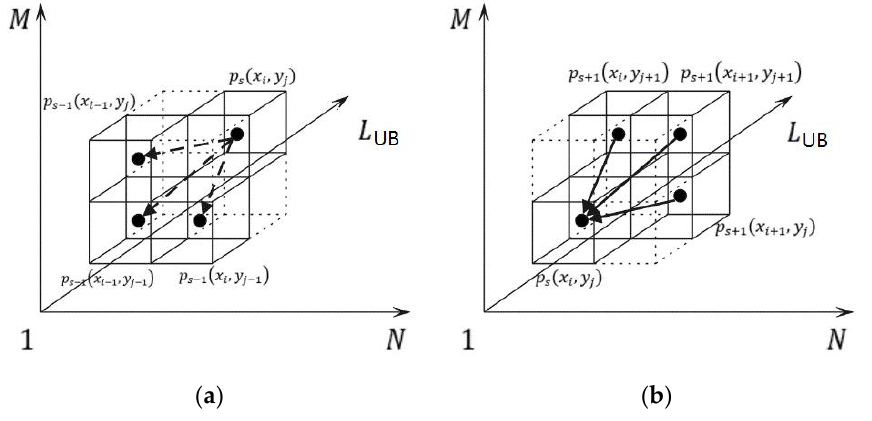
Figure 7. The potential precursor ( a ) and successors ( b ) of a tree node p s ( x i , y j ).